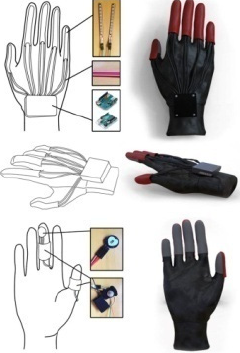
Figure 7. Prototype design of data glove based on emotion recognition of physiological signal.